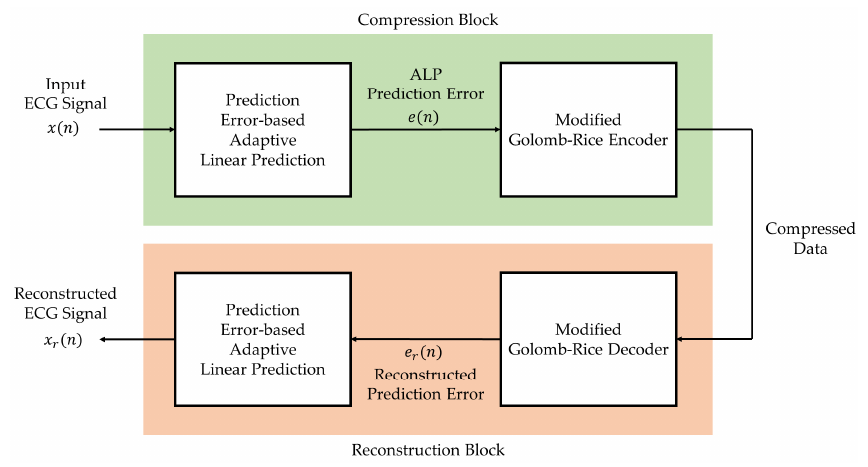
Figure 1. Block diagram of the proposed lossless ECG compression method.